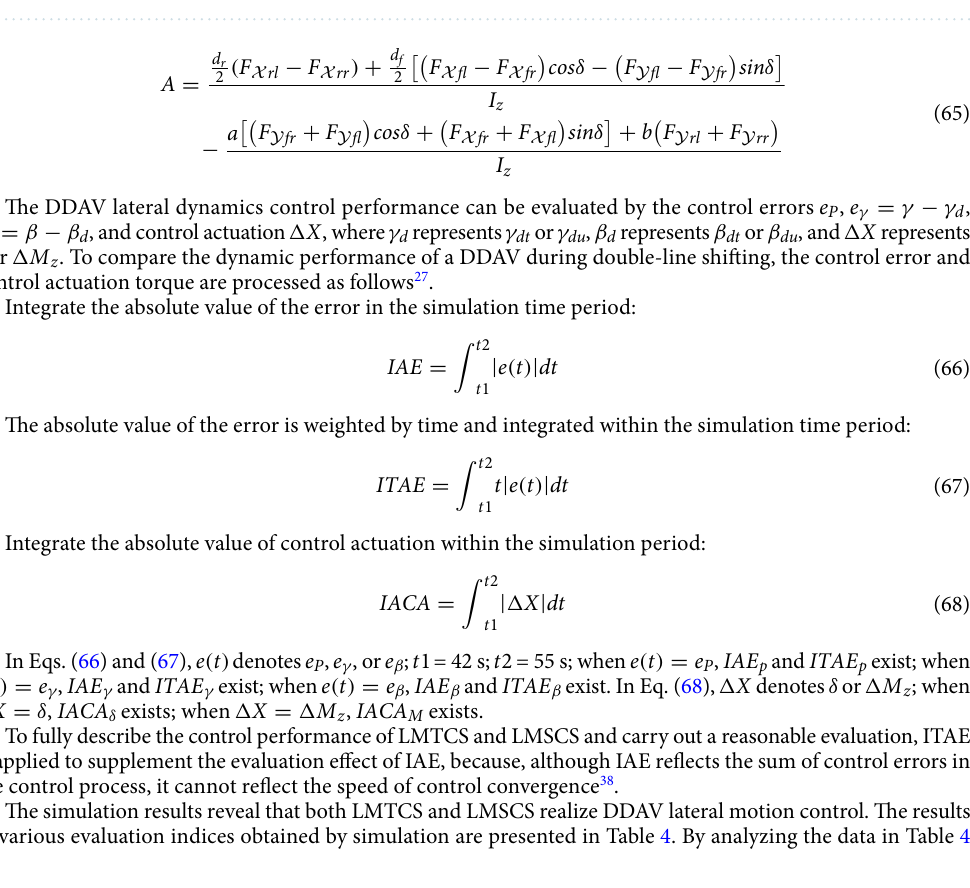
Figure 11. Simulation results of sideslip angle under different road adhesion coefficient and different vehicle speed. ( a ) and ( c ) are the simulation results of DDAV running at 55 km/h on wet road, ( b ) and ( d ) are the simulation results of DDAV running at 65 km/h on dry